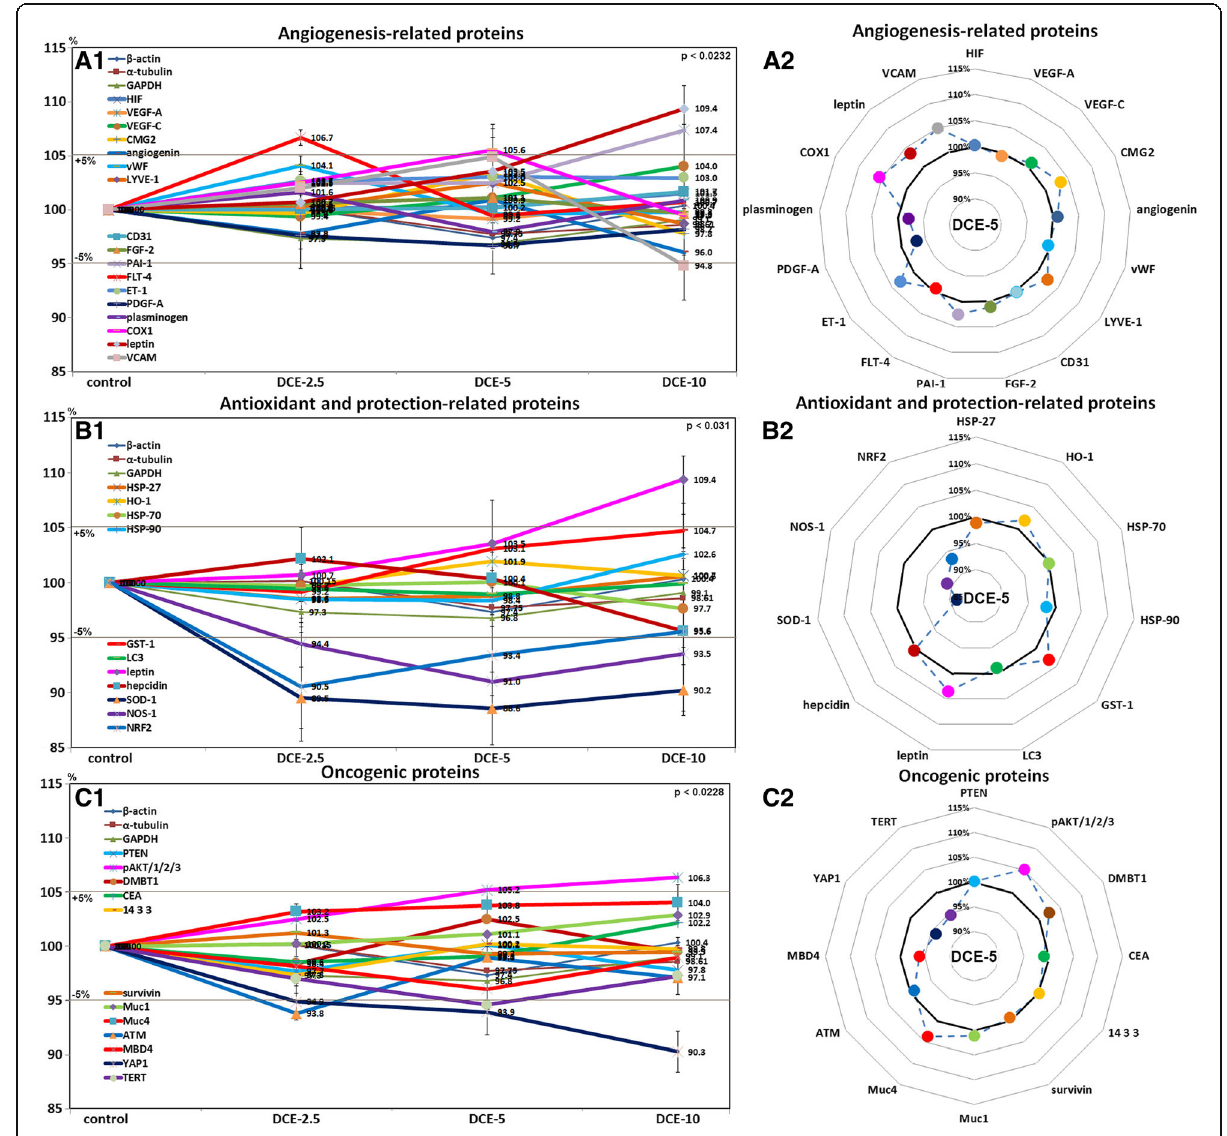
Fig. 7 Expressions of angiogenesis-related proteins ( a ), antioxidant and protection-related proteins ( b ), and oncogenic proteins ( c ) after DCE treatments of mouse livers as determined by IP-HPLC. Major protein expression pattern induced by DCE-5 was found in the radial graphs of A2, B2, C2, and